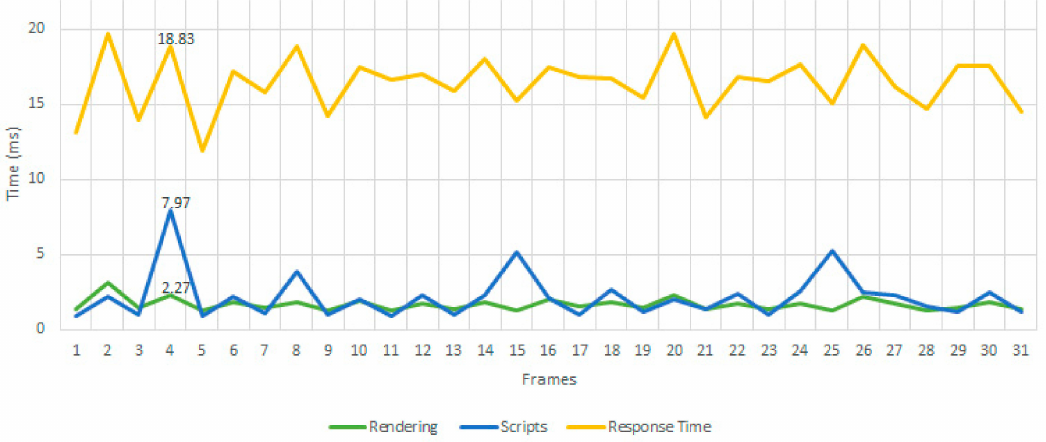
Figure 11. CPU usage of the App